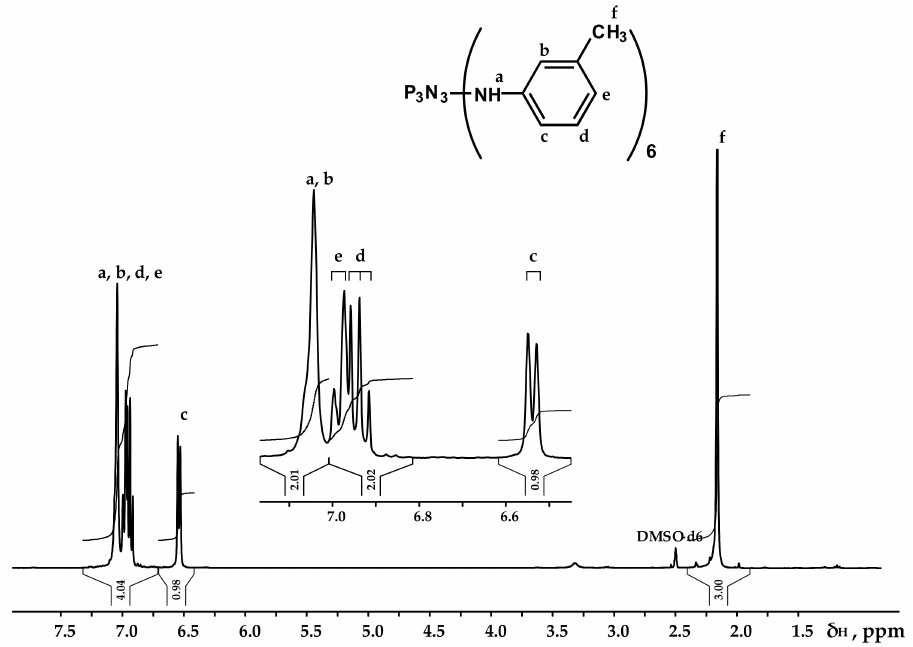
Figure 3. NMR 1 H spectrum of